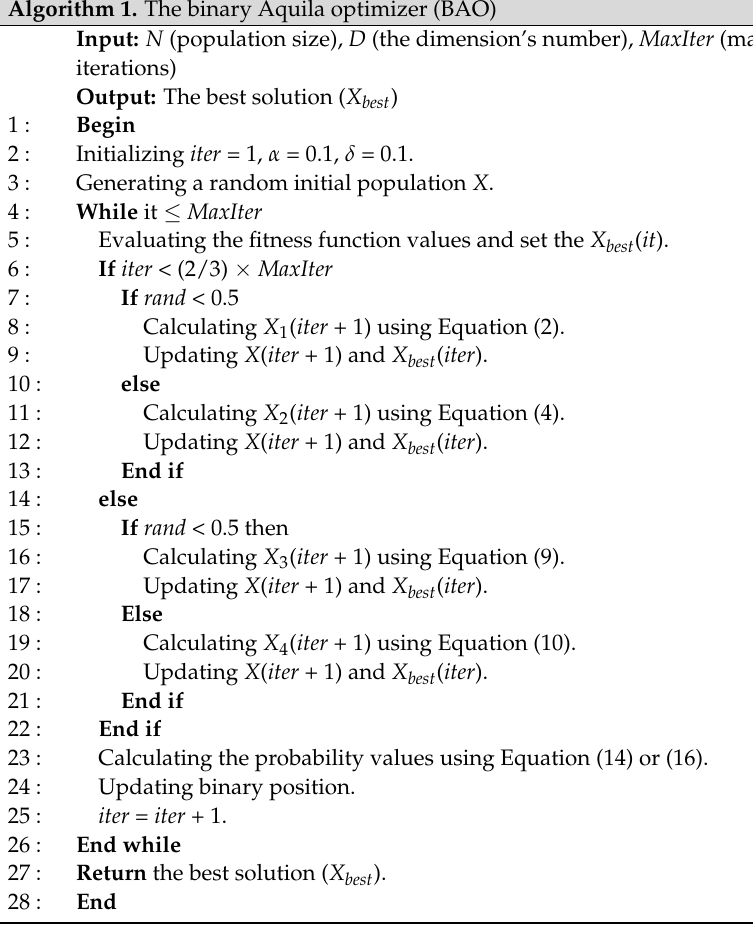
Algorithm 1. The binary Aquila optimizer